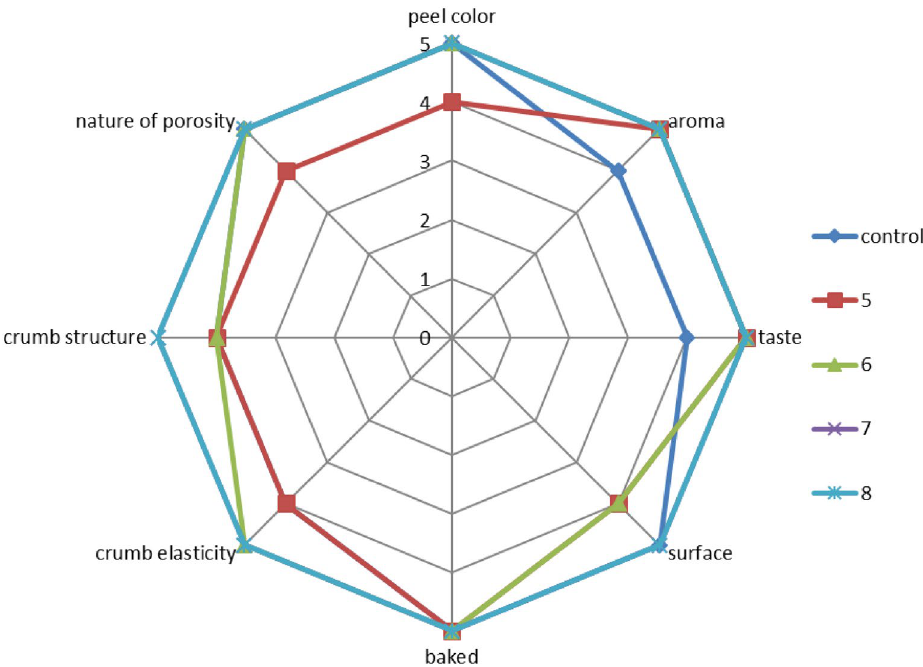
Figure 3. Organoleptic indicators of samples 5–8 in comparison with the